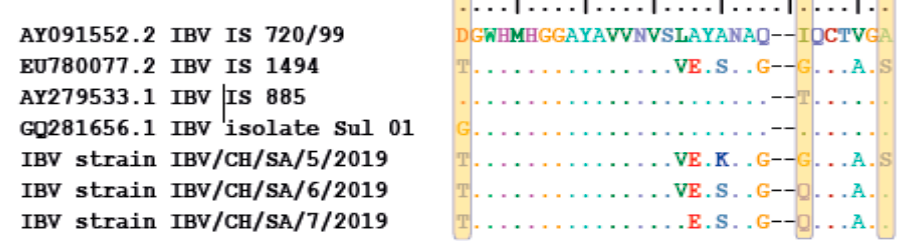
Figure 4. The multi-alignment of residue substitutions associated with virus tropism. ( a ) IBV isolates closely related to 4/91 genotype showed mutations at positions 38, 43, 63, and 69 in comparison with their parental origin (GI-13). ( b ) IBV isolates closely related to IS/720/99 showed mutations at positions 38, 63, and 69 in comparison with their parental origin (GI-23 lineage).